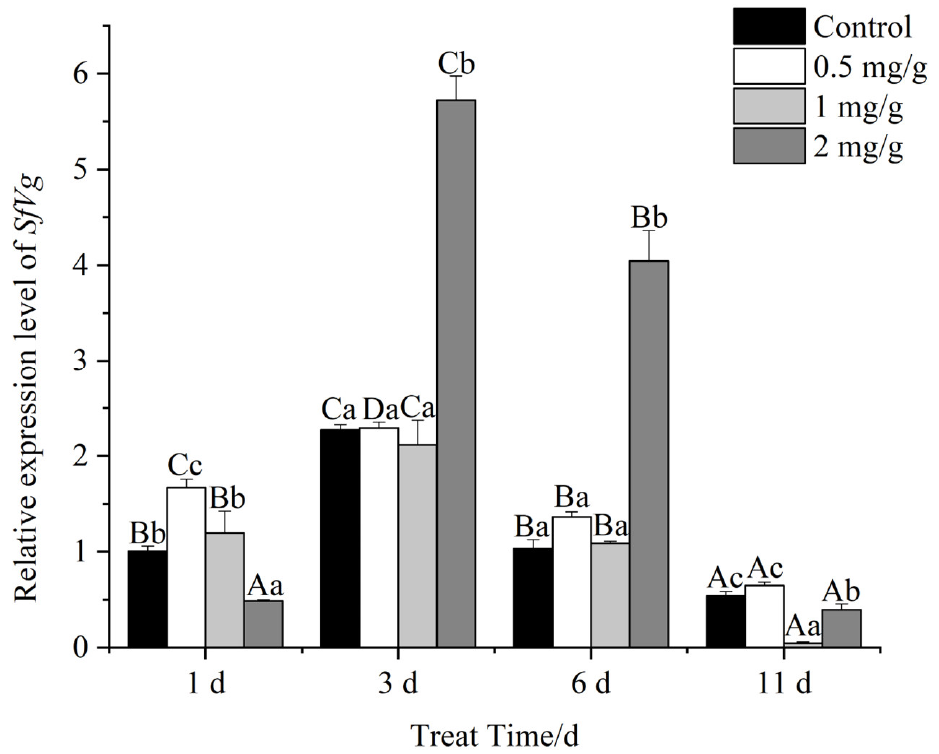
Figure 7. Relative SfVg expression levels in female adults of Spodoptera frugiperda at different develop- mental stages. Data are mean ± standard error. Different lowercase letters indicate that the expression levels of genes treated with different concentrations of GO at the same time are significantly different at p < 0.05 level as tested by Tukey’s HSD method. Different capital letters indicate highly significant differences in gene expression at different times when treated with the same concentration of GO at p < 0.01 level as tested by Tukey’s HSD